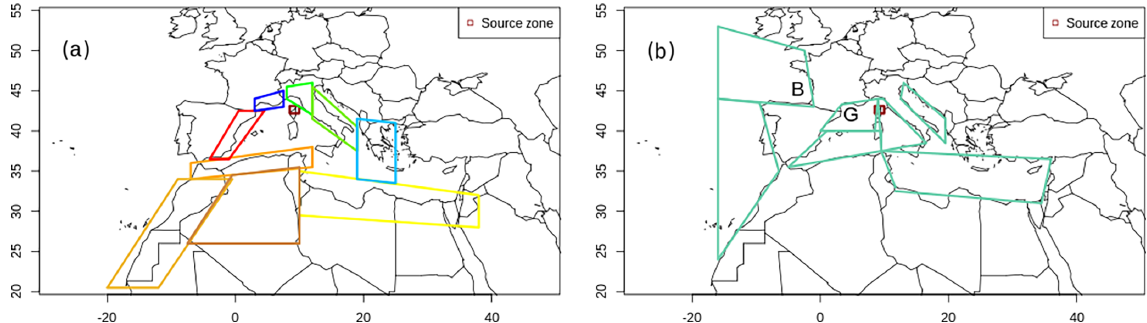
Figure 6. Maps representing the different zones used for the study of the origin of air masses with FLEXPART. (a) Anthropogenic and desert zones (red for Spanish coasts, dark blue for French coasts, green for Italy, blue for Greece, orange and yellow for northern Africa. (b) Marine zones (G corresponds to Gulf of Lion, B to Bay of